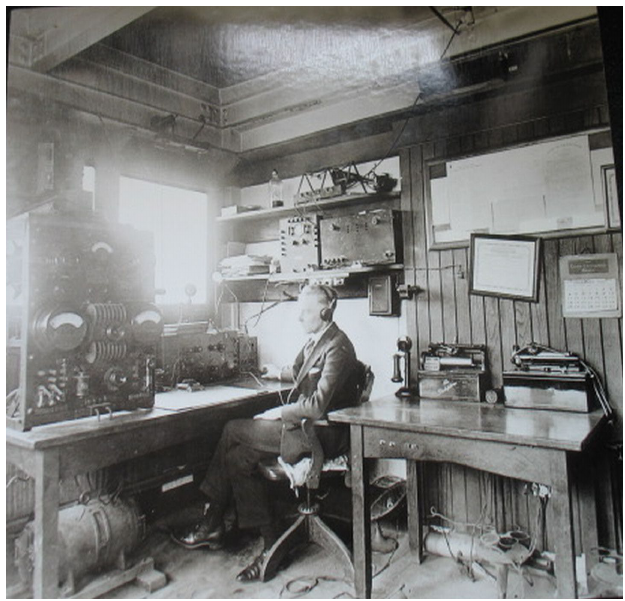
Figure 1 Wireless station on the roof of SCI’s headquarters at